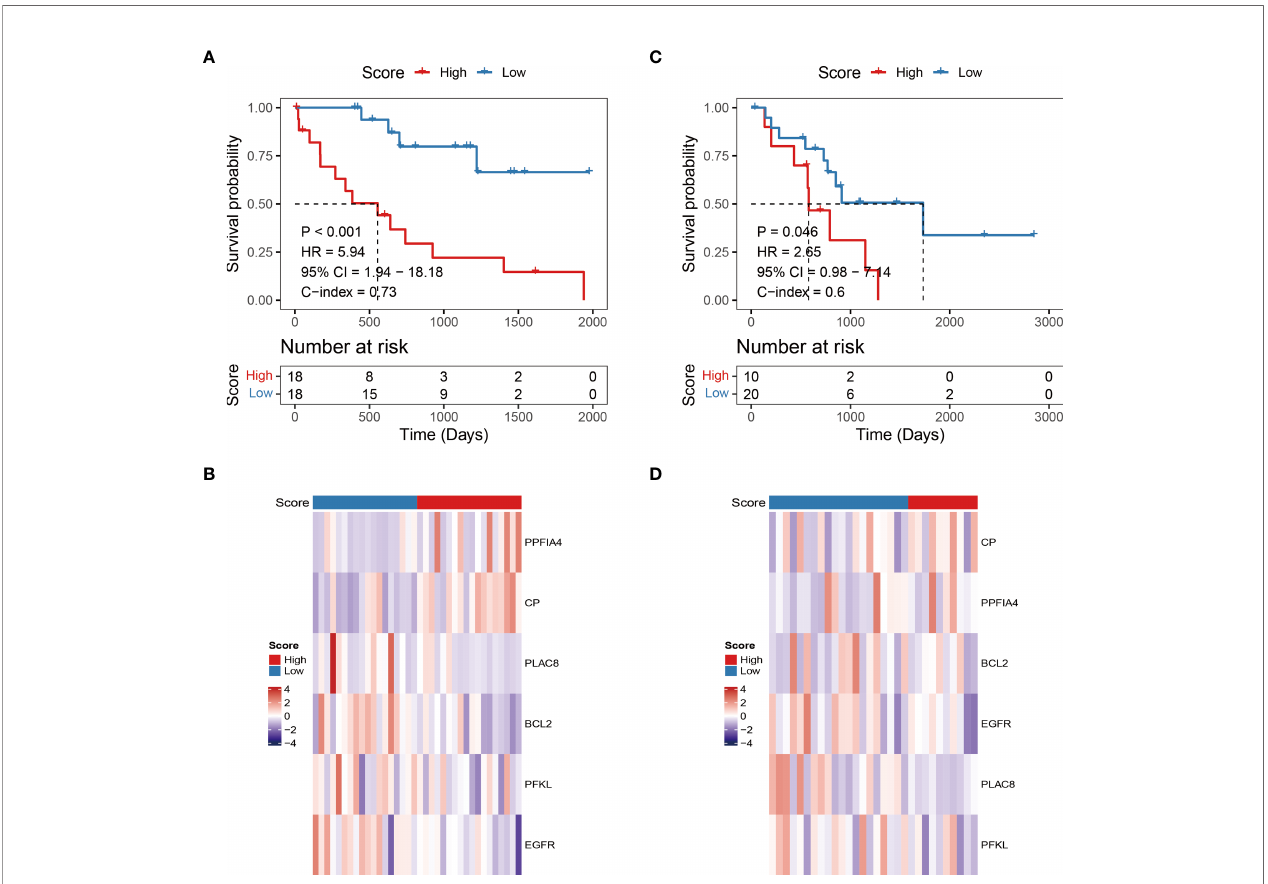
FIGURE 2 | Independent validation of hypoxia-related prognostic models. (A, C) Survival curve for low-risk and high-risk subgroups in the training dataset and validation dataset. (B, D) The expression heat map of the 6 prognostic hypoxia-related signatures in low-risk and high-risk subgroups training dataset and validation